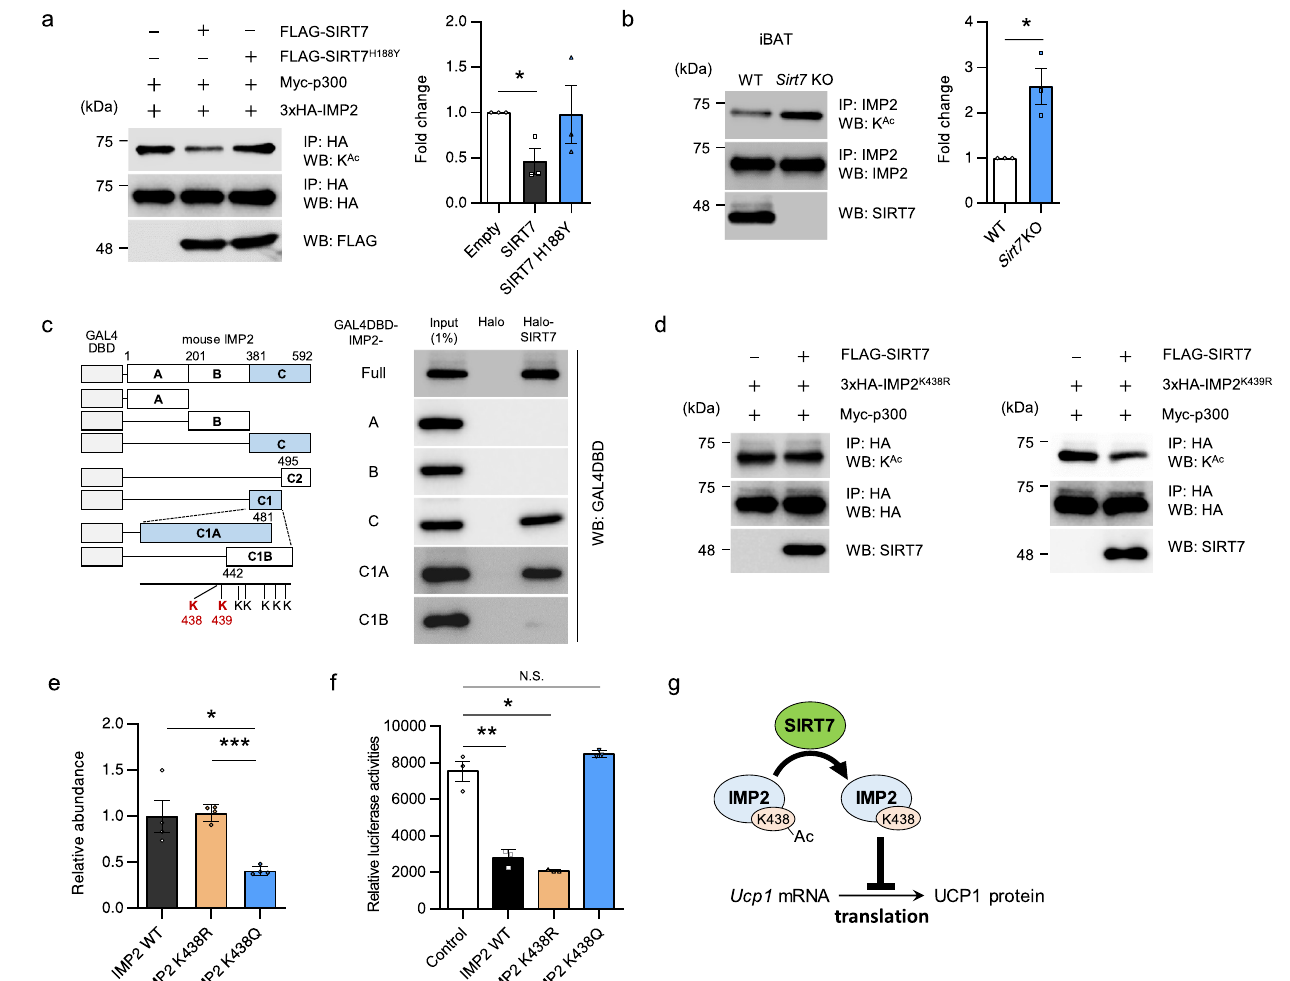
Fig. 8 | Deacetylation of IMP2 by SIRT7 attenuates the translation of Ucp1 mRNA. a The effect of SIRT7 overexpression on IMP2 acetylation. HEK293T cells were transfected with the indicated expression plasmid, and IMP2 acetylation was assessedbyIPandWB(leftpanel).Quanti fi cationoftheacetylatedIMP2relativeto IMP2 ( n =3) (right panel). p =0.0174. b The effect of Sirt7 de fi ciency on IMP2 acetylation. Proteinlysates of iBAT weresubjectedto IP, afterwhichthe acetylated IMP2wasdetectedbyWB(leftpanel).Quanti fi cationoftheacetylatedIMP2relative to IMP2 ( n =3) (right panel). p =0.0170. c Mapping of the region of the interaction